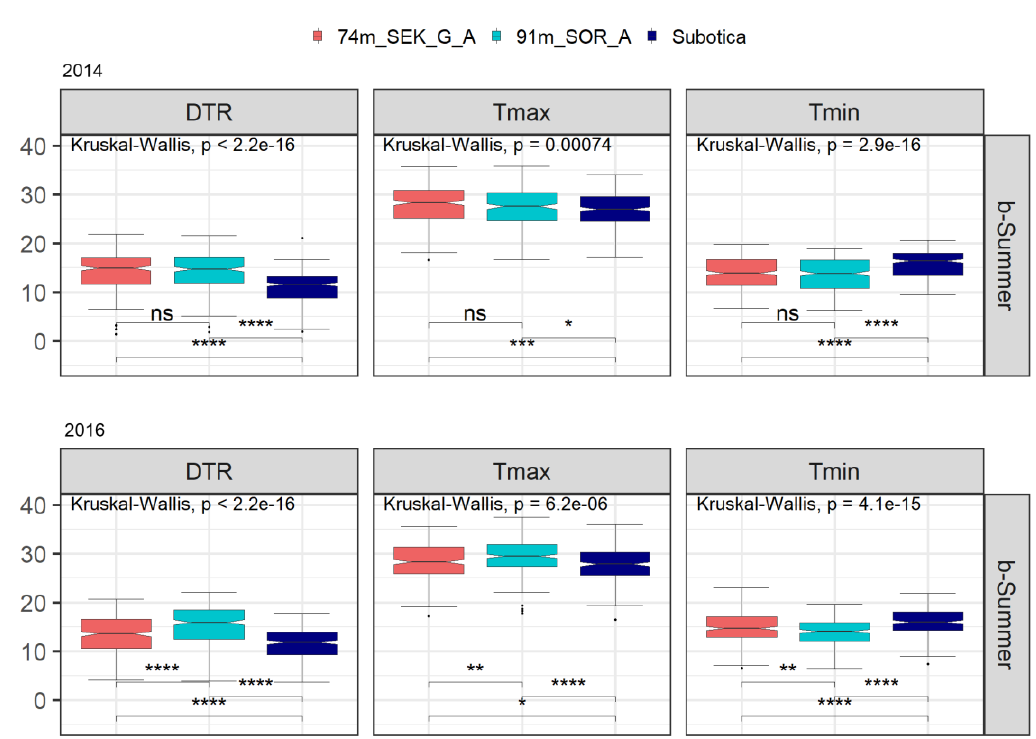
Figure 5. T max , T min , and DTR measured on the AWSs located in the apple orchards (74m_SEK_G_A—clay soil, 91m_SOR_A—sandy loam) and climatological station Subotica in the R2 region during the summer 2014 (sample size 90) and 2016 (sample size 91) (all years are in Supplementary S1, Figures S1.1 and S1.2). The following convention for symbols indicates statistical significance: (not significant (ns): p > 5 × 10 −2 ), (*: p ≤ 5 × 10 −2 ), (**: p ≤ 1 × 10 −2 ), (***: p ≤ 1 × 10 −3 ), (****: p ≤ 1 × 10 −4 ) number of stars indicate growing differences between data distribution.